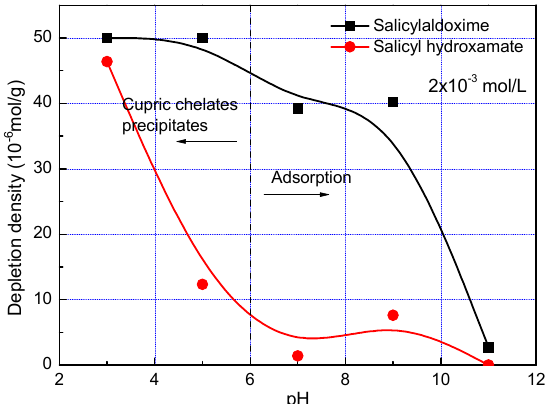
Figure 4. The depletion of salicyl hydroxamate and salicylaldoxime in malachite slurry as a function of pH.